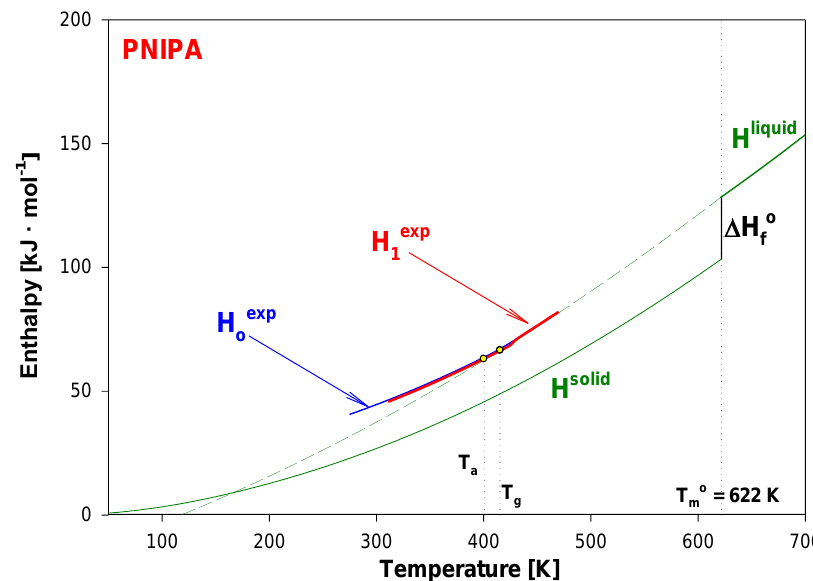
Figure 10. Experimental enthalpy of aged (H 1exp ) and unaged (H oexp ) of PNIPA versus temperature in the frame of equilibrium enthalpy of solid (H solid ) and liquid (H liquid ). Analysis is presented for sample of poly( N -isopropylacrylamide) isothermally aged at 400.15 K for 1 year.